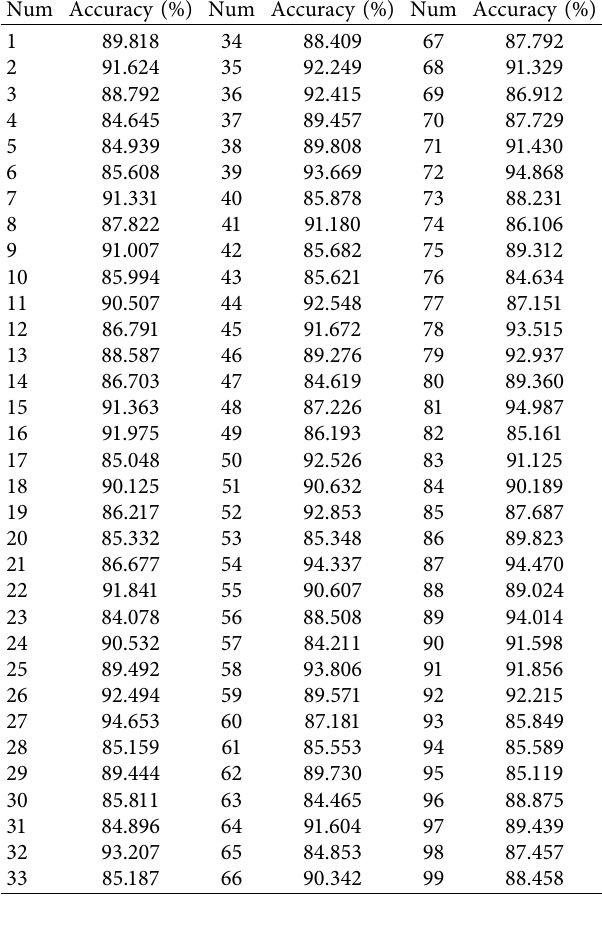
Table 2: Statistical table of the accuracy rate of video recognition of mobile phone core wires.